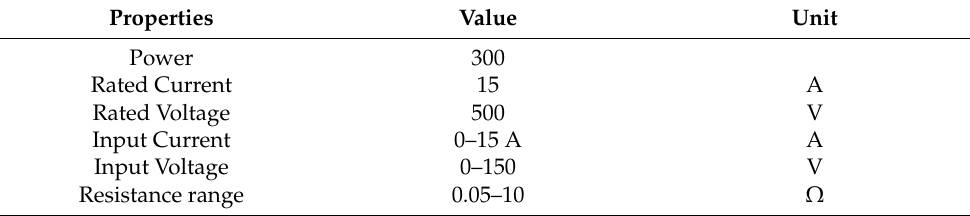
Table 4. BK 8500B